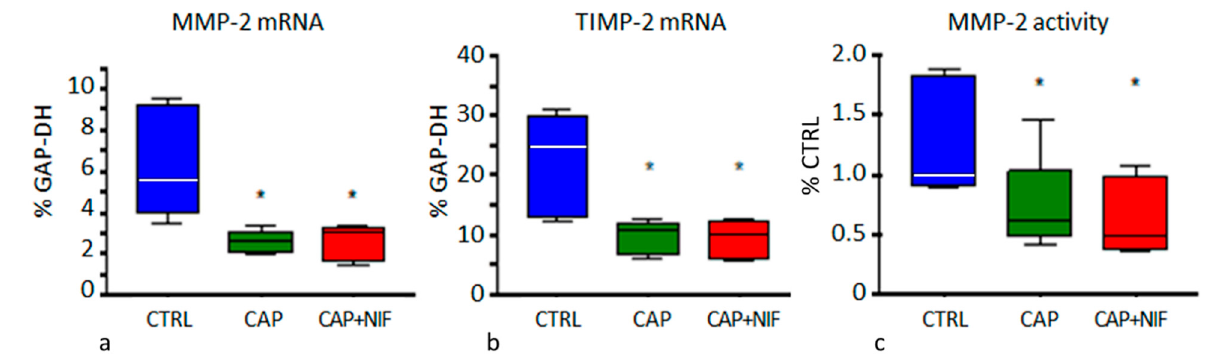
Figure 4. ( a , b ): MMP-2- and TIMP2 mRNA expression (in % of GAP-DH) in the LV. ( c ): MMP-2 activity (in % of CTRL) in the LV. Data are given as median (line in the box) with 25th/75th percentiles (boxes) and 10th/90th percentiles (whiskers). All values were obtained from 82-week-old SHR. Significance marks: * significant vs. CTRL.